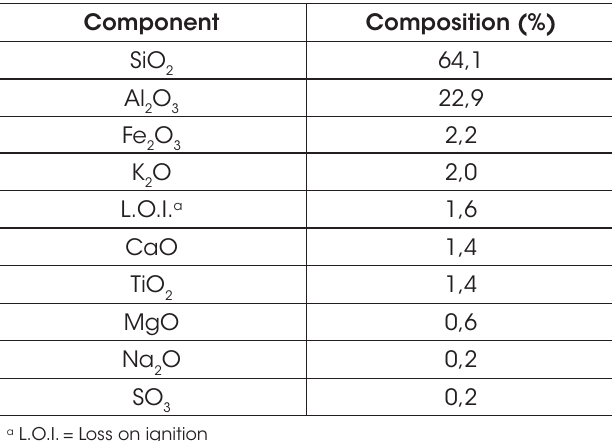
Main chemical composition of fly ash (%